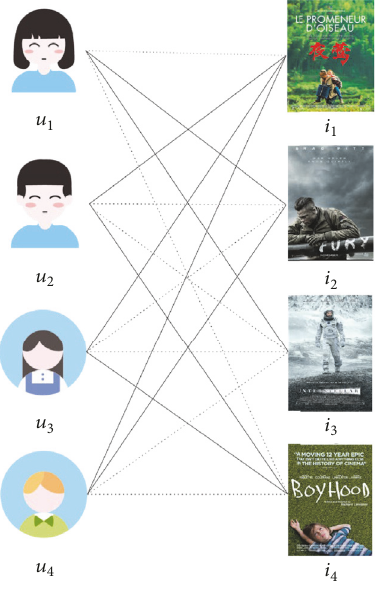
Figure 1: Illustration of a simple